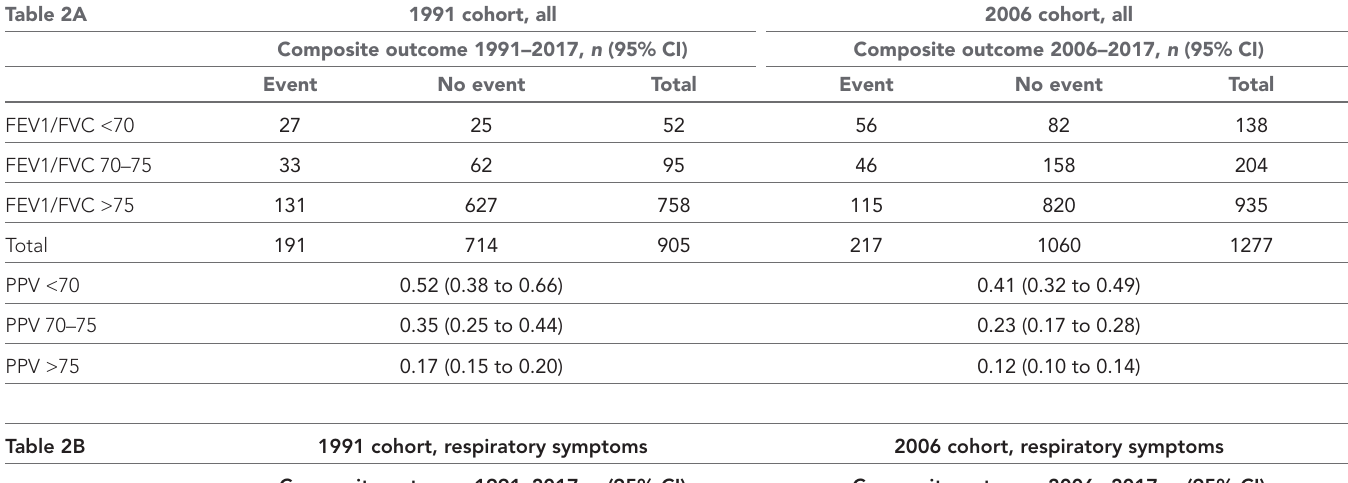
1991 cohort, respiratory symptoms